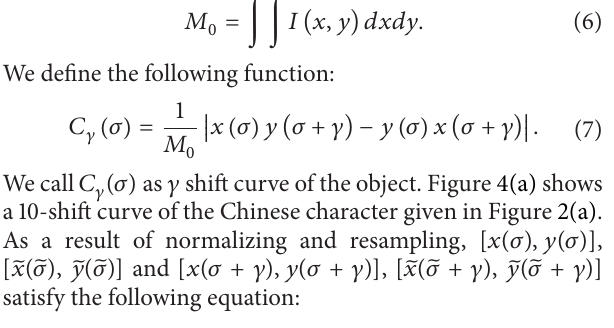
3.1. Affine Invariant Parameterization. GC should be param- eterized to establish one-to-one relation between points on GC of the original object and those on GC of its affine transformed